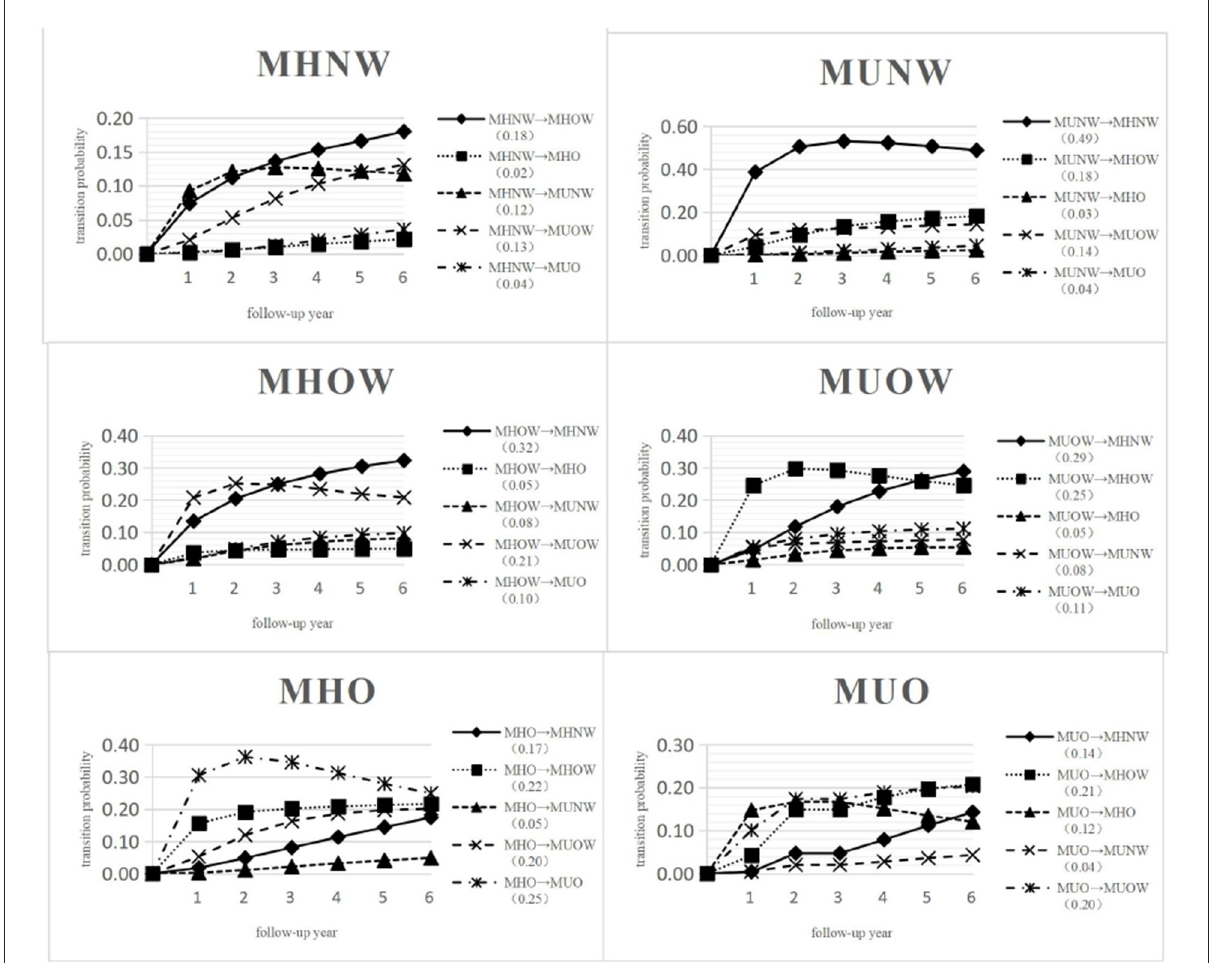
FIGURE3 Predicted probabilities of transition from MHNW, MHOW, MHO, MUNW, MUOW, MUO to any other state over 6 years. MHNW, metabolically healthy normal weight; MHOW, metabolically healthy overweight; MHO, metabolically healthy obesity; MUNW, metabolically unhealthy normal weight; MUOW, metabolically unhealthy overweight; MUO, metabolically unhealthy